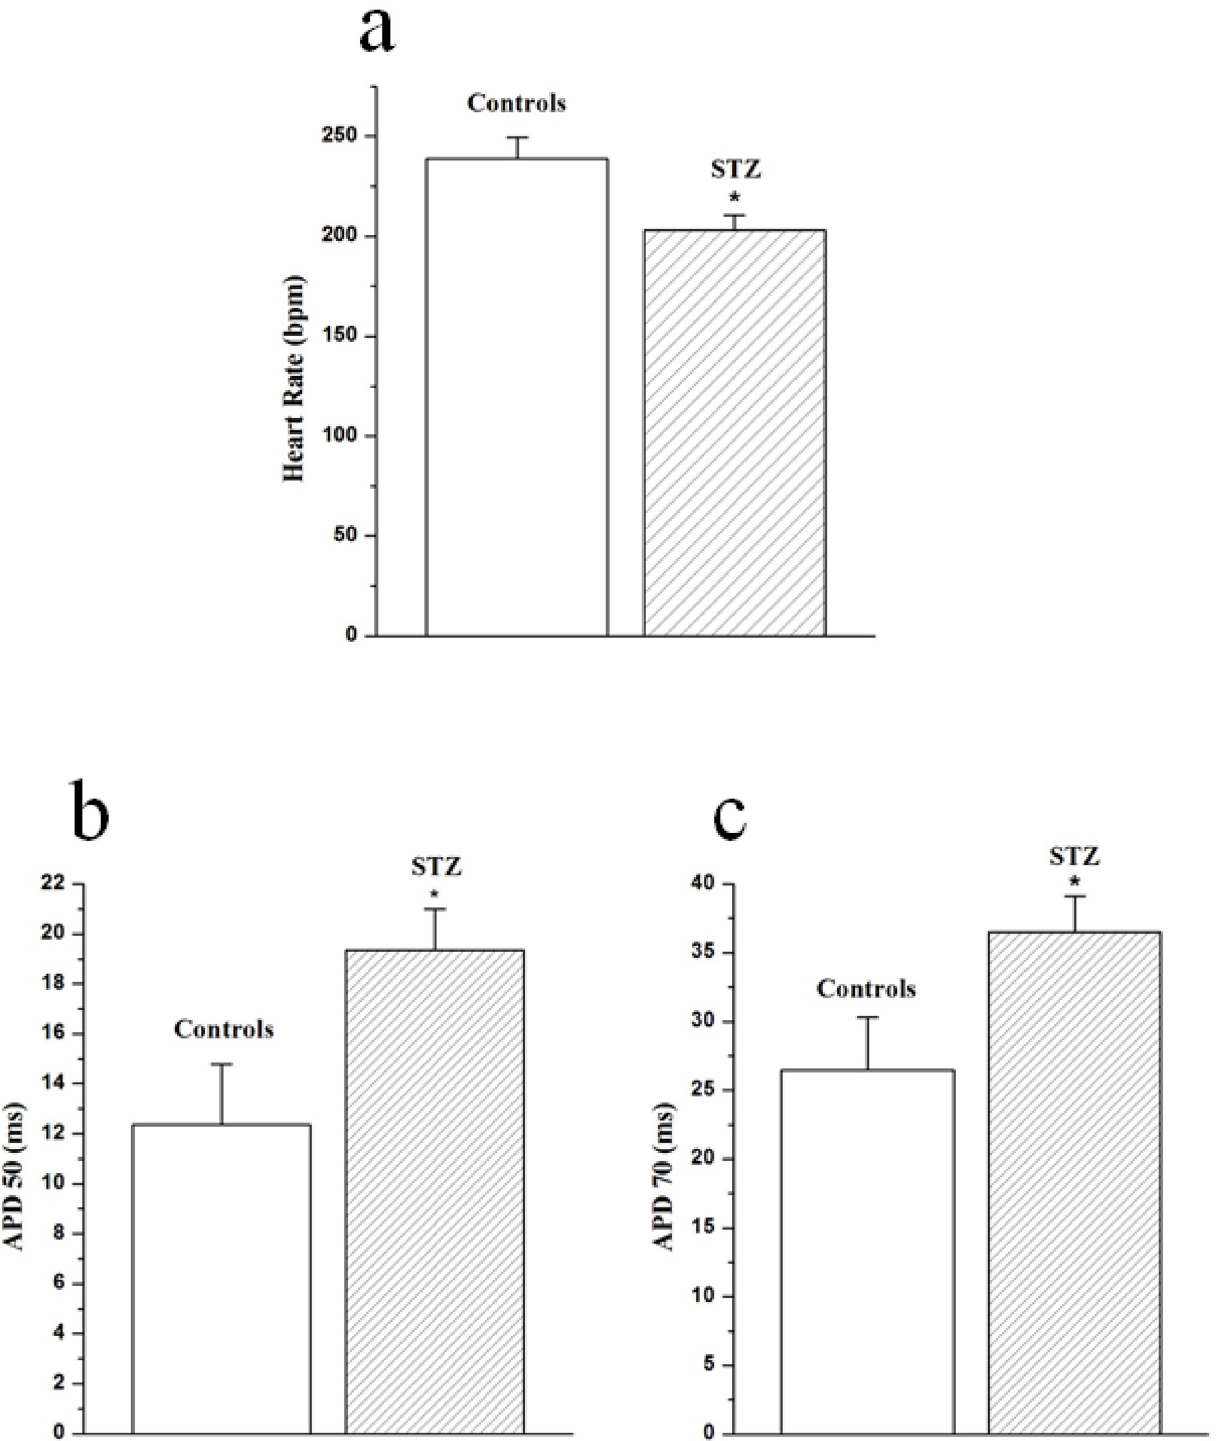
Fig 2. Effects of STZ-induced diabetes on heart rate (a), action potential duration at 50% (b) and 70% (c) recovery from peak action potential. Data are mean ± SEM, n = 12 hearts.